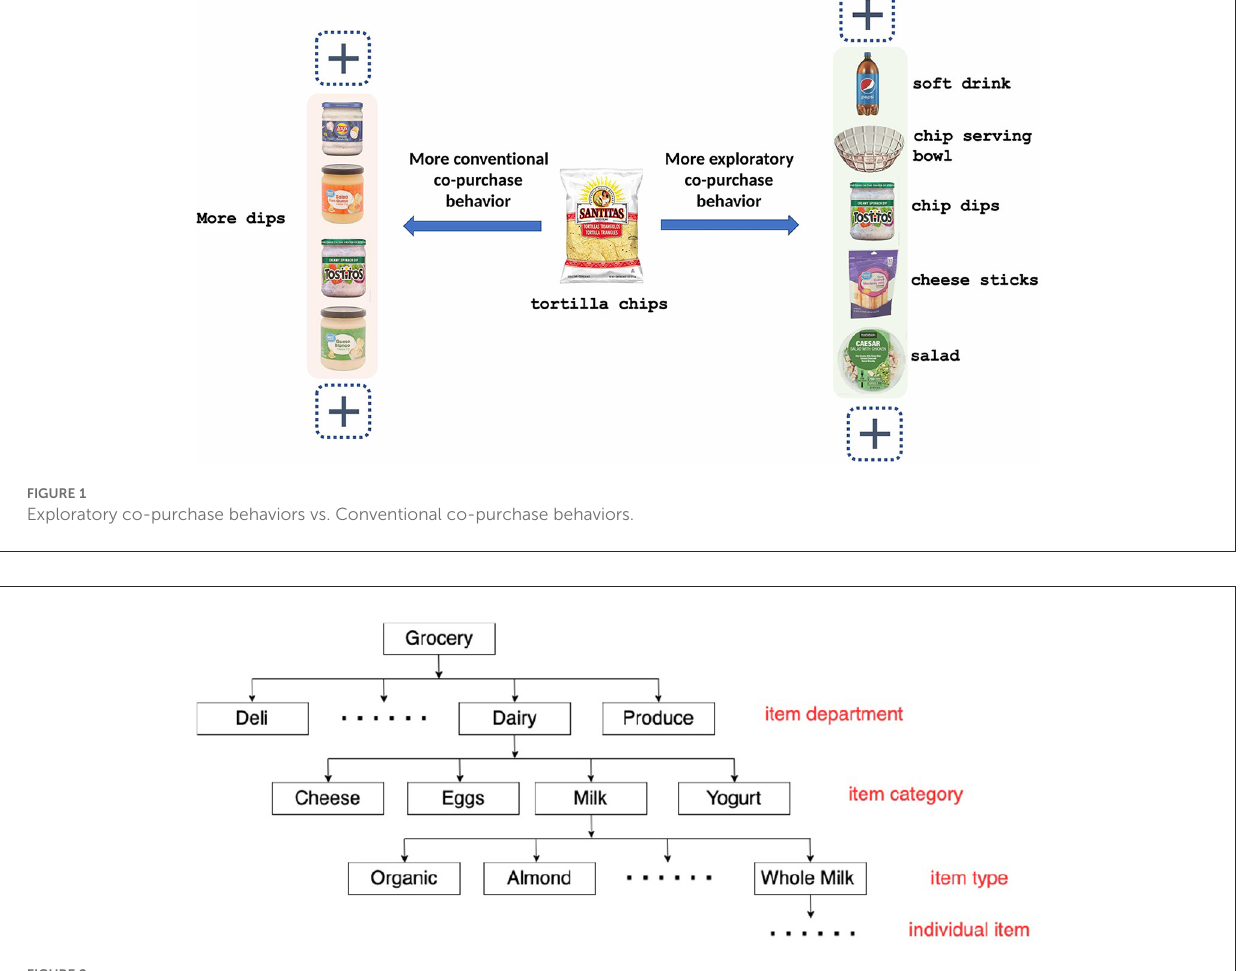
FIGURE2 An example of grocery item